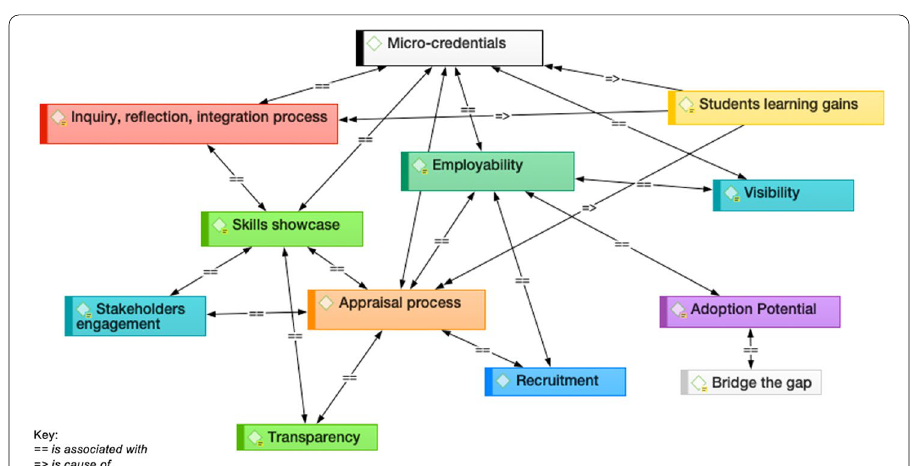
Fig. 8 Network of the semantic linkages between codes emerging from the employer